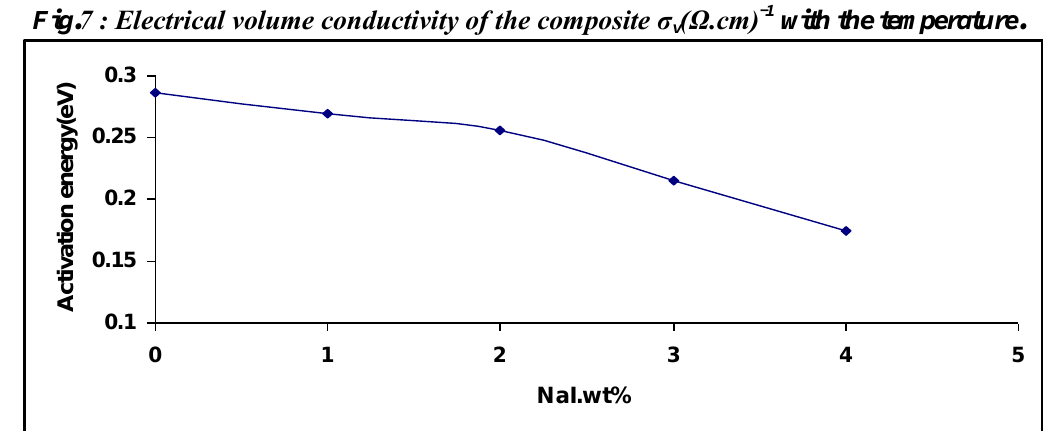
Fig.7 : Electrical volume conductivity of the composite σ